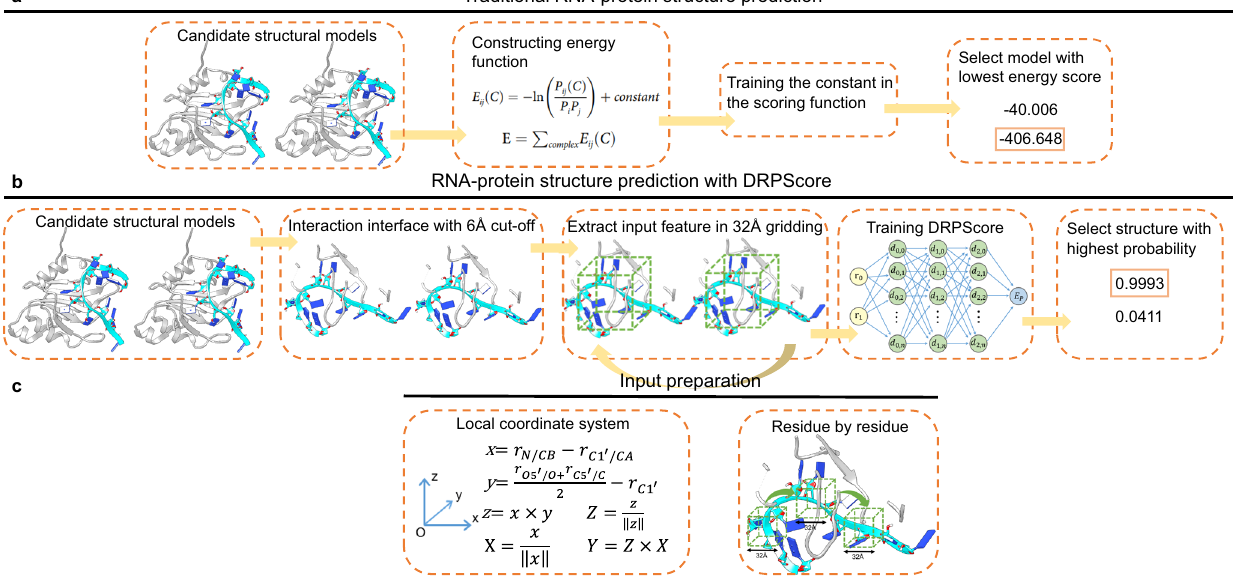
Fig. 5 | Flow charts comparing DRPScore and traditional scoring functions. a The steps of traditional scoring function based on statistical potential energy to